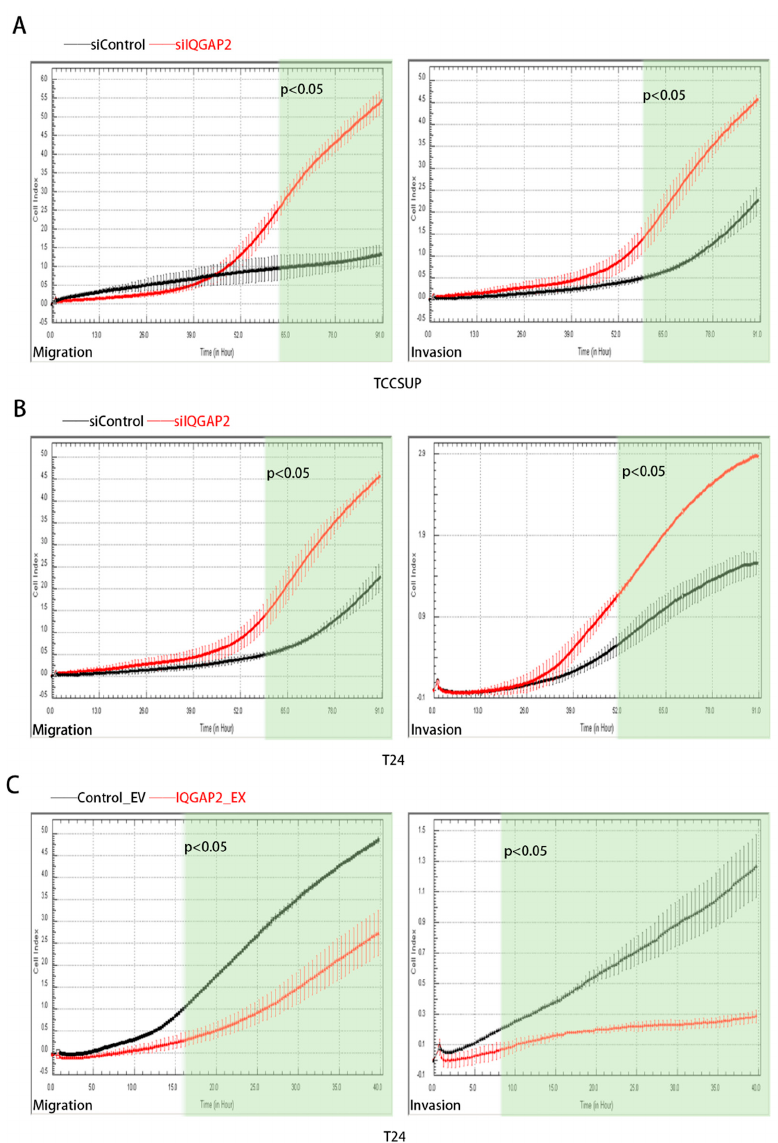
Figure 4. IQGAP2 influenced migration and invasion of bladder cancer cells. ( A ) Migration and invasion were significantly increased after knockdown of IQGAP2 in TCCSUP. ( B ) Migration and invasion were significantly increased after knockdown of IQGAP2 in T24. ( C ) Migration and invasion were significantly decreased after overexpression of IQGAP2 in T24. Bar chart presents the means of replicates ± SEM from three different experiments; Student’s t-test (two-tailed, unpaired) was used for comparison of means.